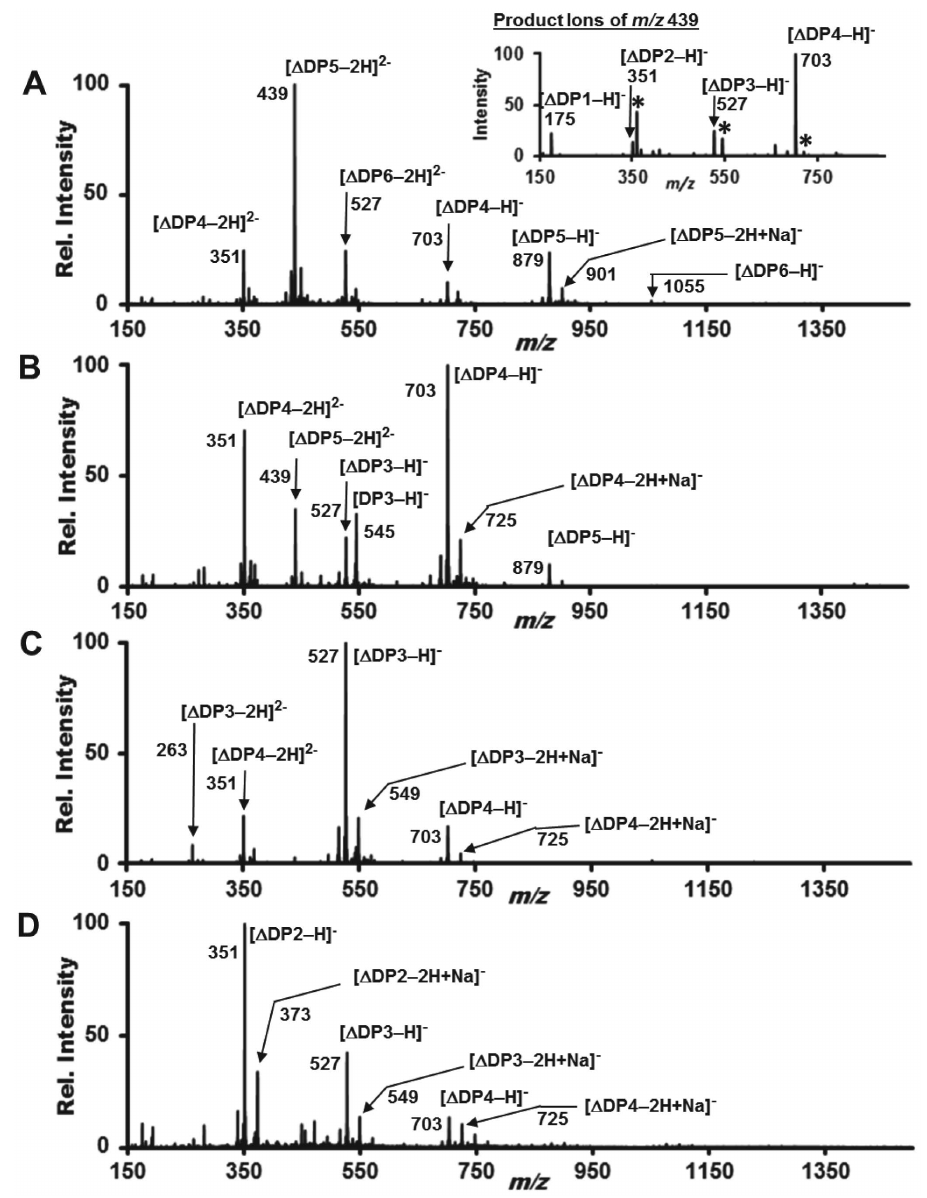
Figure 6. ESI-mass spectrometry analyses of peak fractions from FPLC separation of the oligo-uronates from AlgMsp digestion of alginate. DPx is degree of polymerization. DPx and D DPx represent saturated and unsaturated oligo-uronates, respectively. (A) Mass spectrum of FPLC fraction 1, the 13.4 ml elution peak, showing predominance of D DP5 eluent. Inset: MS/MS product ion spectrum of m/z 439 peak, showing the methodology used to elucidate the structure of all observed ESI-MS anion peaks. The m/z 703 and m/z 721 peaks are indicative of the double charge of the precursor anion, m/z 439. The annotated peak series, {[ D DP x -1H] 2 , x =1–4}, and the peaks denoted with asterisks ([DP4-2H] 2 2 ( m/z 360), {[DP3- H] 2 ( m/z 545), and {[DP4-H] 2 ( m/z 721), confirm that the composition of the m/z 439 precursor anion, is consistent with [ D DP5-2H] 2 2 . (B) Mass spectrum of FPLC fraction 2, the 14.0 ml elution peak, showing predominance of D DP4 eluent. (C) Mass spectrum of FPLC fraction 3, the 14.7 ml elution peak, showing predominance of D DP3 eluent. (D) Mass spectrum of FPLC fraction 4, the 15.6 ml elution peak, showing predominance of D DP2 eluent.